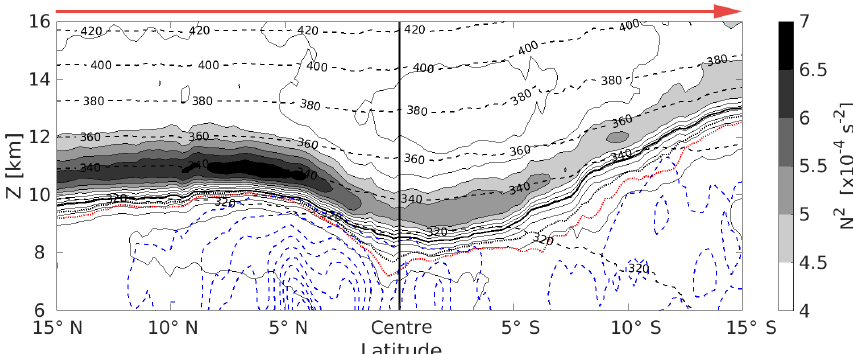
Figure 9. Vertical cross section of the mean state from the 76 strong cyclones, from north to south through the centre of the cyclone, as indicated by the red arrow here and in Fig. 7b. The cross section is composed of the tropopause-based mean of vertical profiles at each latitude. The mean tropopause height has been restored. Filled contour as well as solid black contour lines show static stability N 2 in steps of 0 . 5 × 10 − 4 s − 2 , dashed black lines isentropes, and dashed blue lines the cloud ice water content (ciwc), with the first isoline at 5 × 10 − 6 kgkg − 1 and steps of the same value. The bold solid black line indicates the lapse rate tropopause, the dotted red (black) line the 2pvu (2.5pvu) isoline of potential vorticity, indicating near-tropopause PV